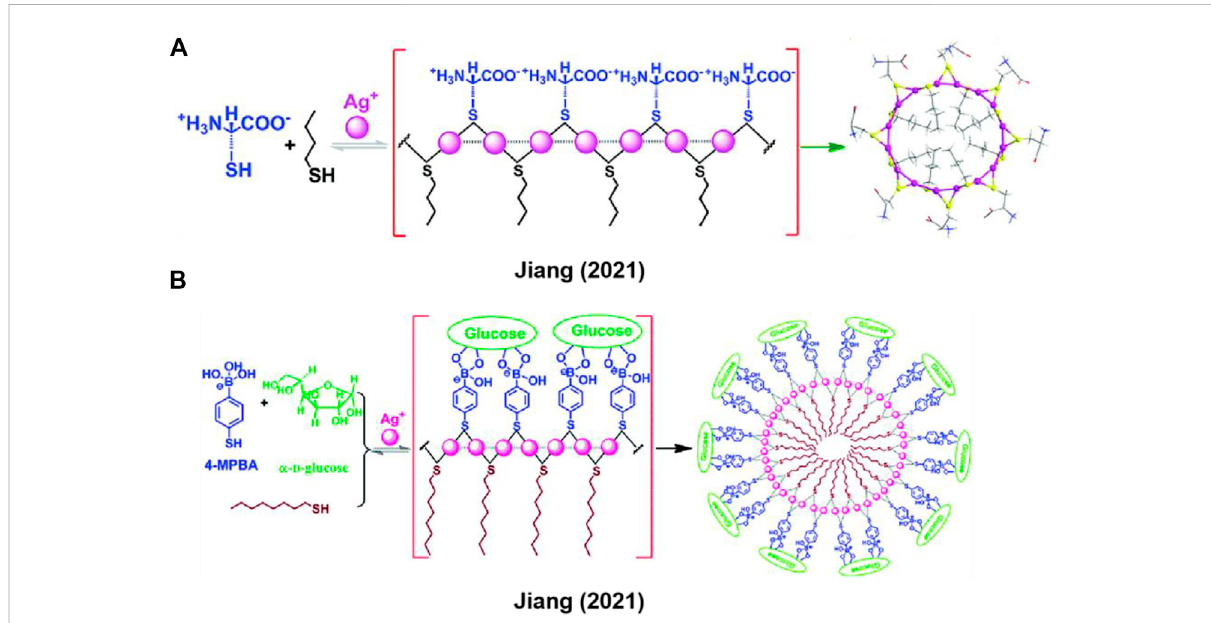
FIGURE 2 (A,B) Thiol-containing amphiphilic ligands coordinated with Ag + to generate macrocyclic complexes. Adapted with permission from ref (Xu et al., 2021a; Xu et al.,